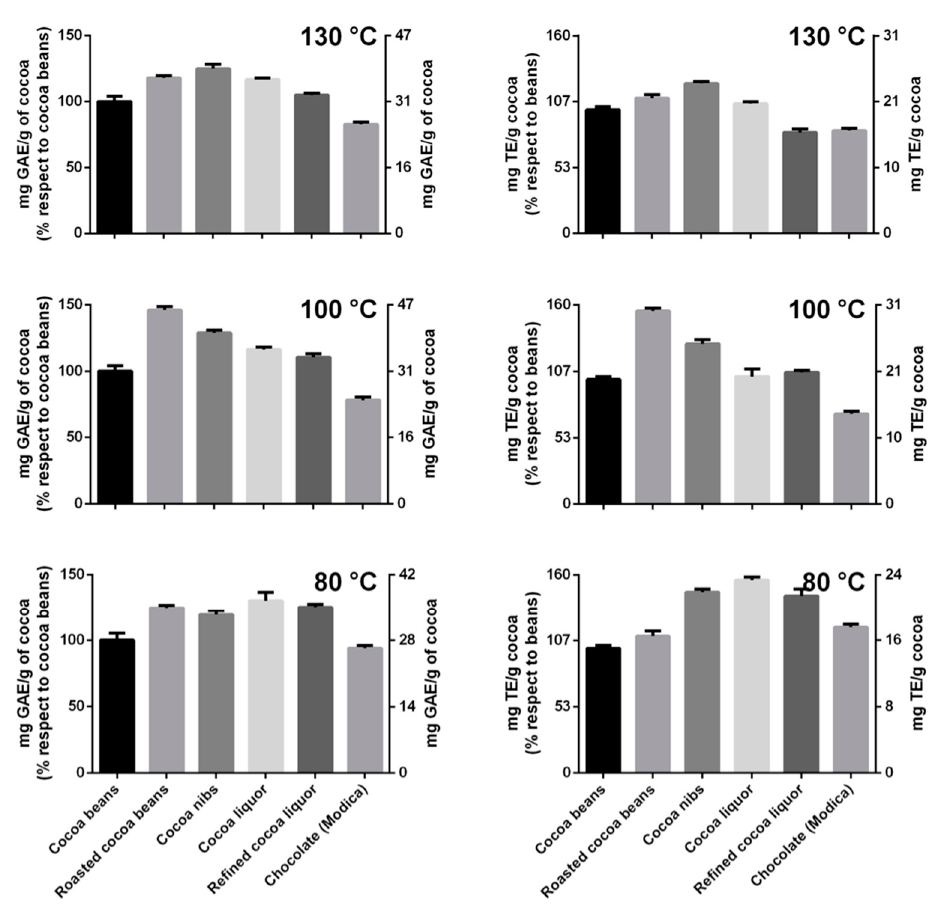
Figure 4. Data of TPC determined by Folin–Ciocalteu assay ( left plots) and TAC determined by FRAP assay ( right plots).